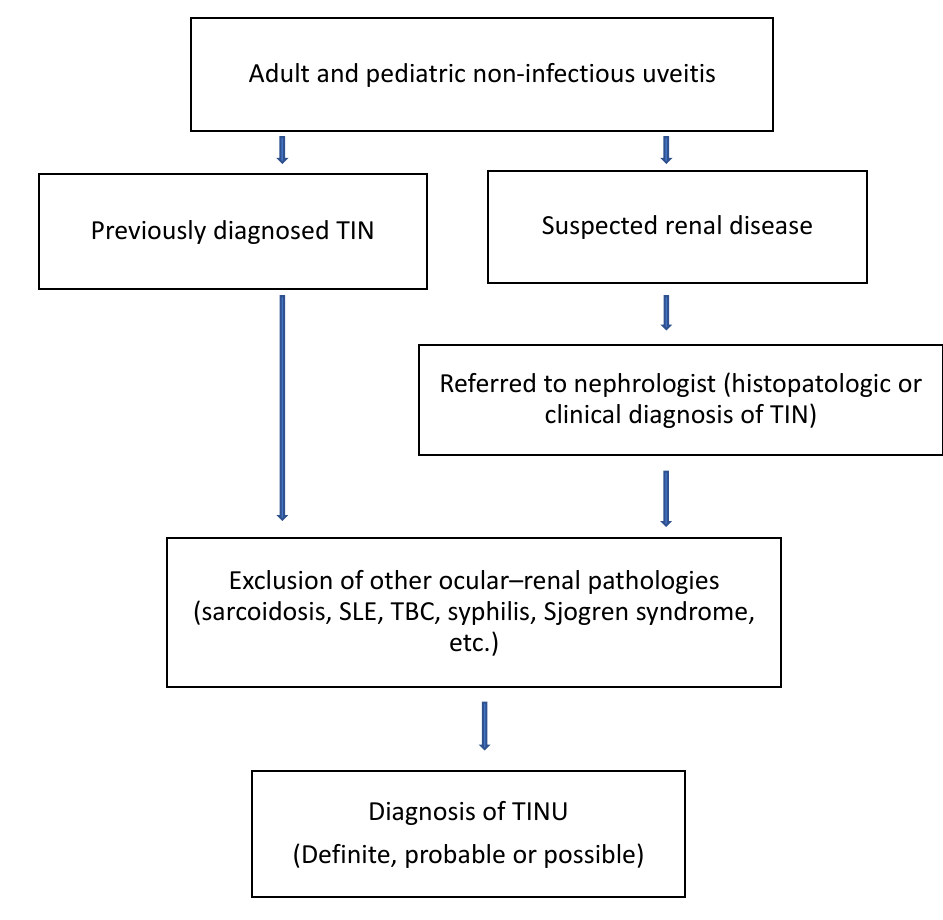
Figure 1. Flow chart showing the screening procedure followed to identify patients meeting the diagnostic criteria of TINU. TIN, tubulointerstitial nephritis, SLE, systemic lupus erytematosus, TBC, tuberculosis, TINU, tubulointerstitial nephritis and uveitis syndrome. Other associated ocular findings, including cystoid macular edema (CME), papilledema, peripheral vasculitis, peripapillary choroidal neovascularization (CNV), and multifocal choroiditis, were also recorded. Tubulointerstitial nephritis (TIN) was di- agnosed in 6 cases by kidney biopsy and in the remaining cases by typical acute kidney injury (AKI) presentation, characterized by abnormal renal function, an abnormal urinal- ysis, and systemic illness lasting ≥2 weeks according to the recognized international clin- ical criteria. Data on kidney function were collected in collaboration with the renal center of our institution [2,11,12]. The eGFR was calculated according to the Chronic Kidney Dis- ease Epidemiological Collaboration (CKD-EPI) formula [13] The presence of autoantibod- ies, including ANA and/or ANCA, was also investigated.